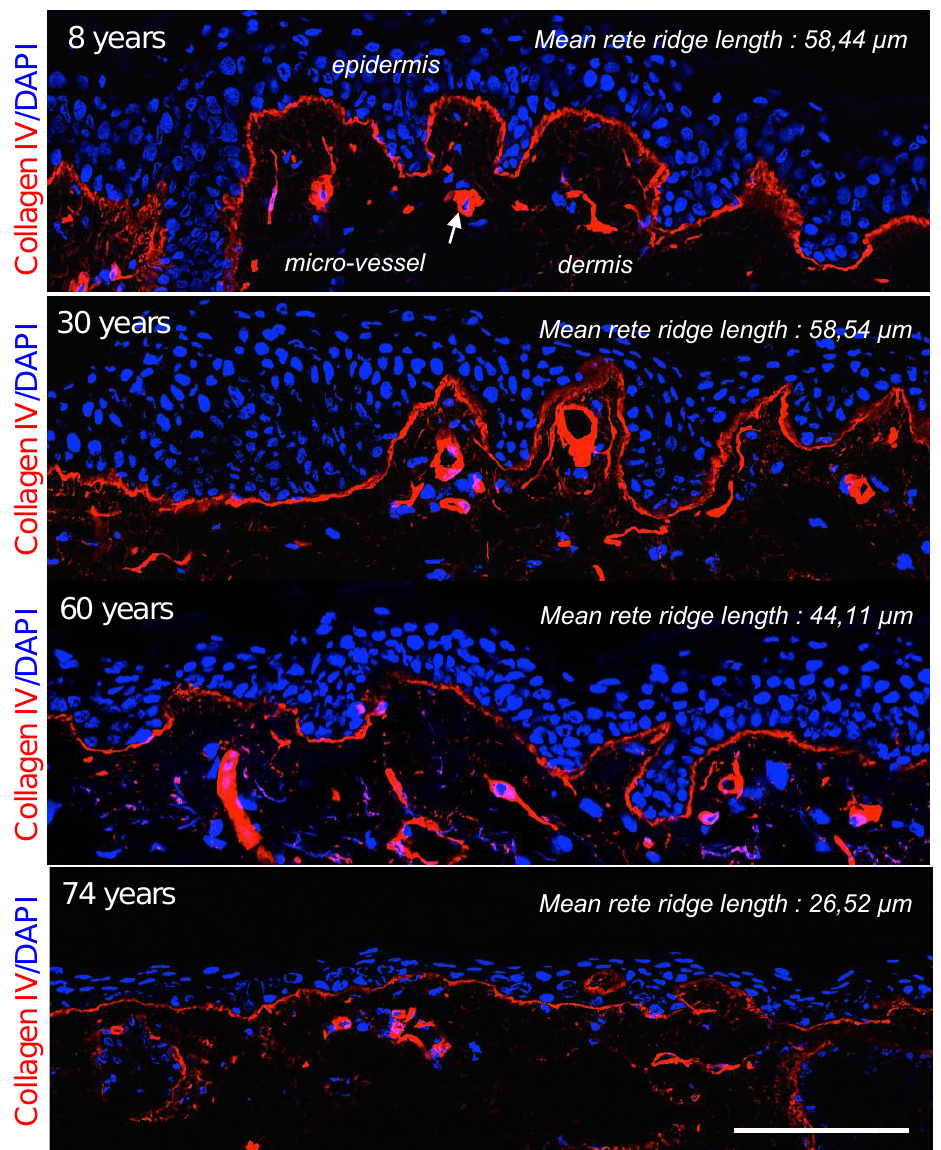
Figure 3. Collagen IV expression in facial human skin from female donors aged 8, 30, 60 and 74 years. Sections of frozen Tissue-Tek ® O.C.T.™ -embedded skin biopsies were stained with the monoclonal anti-collagen IV antibody (Clone 94, Sigma-Aldrich, St. Quentin Fallavier, France) and the nuclei were stained with DAPI. Note the regular lessening of collagen IV labeling at the dermal-epidermal junction and the gradual disappearance of rete ridges with the increase in the age of donors. Epidermis, dermis, micro-vessels and the mean rete ridge length ( n = 10) are indicated. Scale bar = 100 μm .